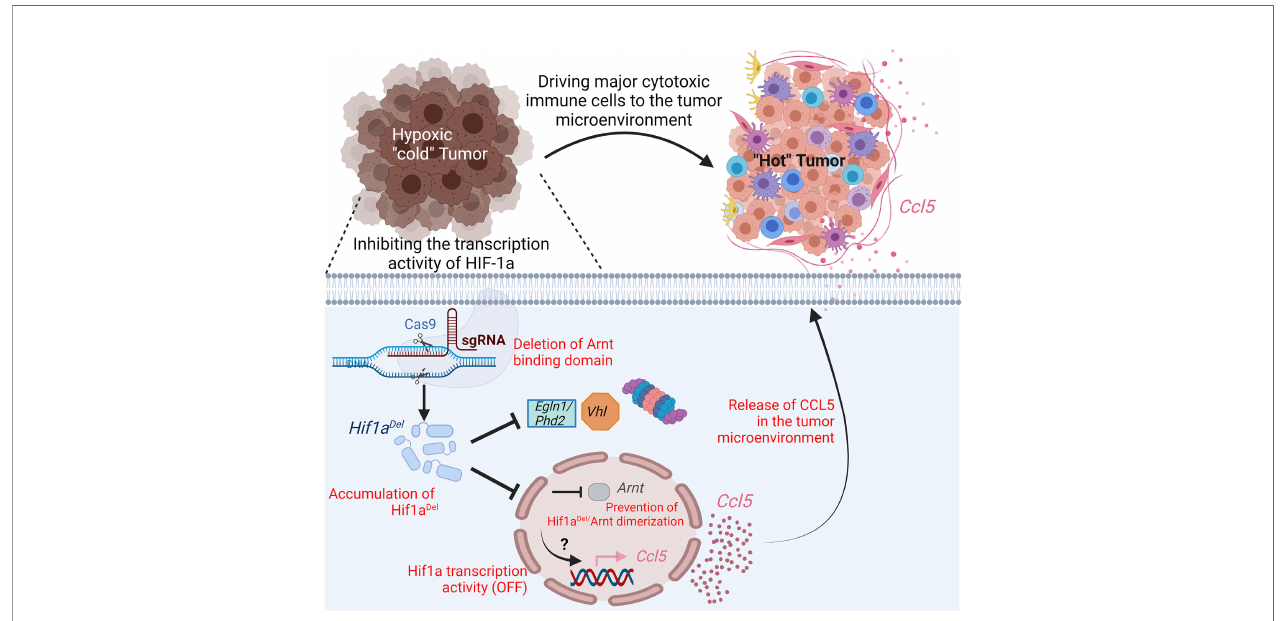
FIGURE 3 | Impact of targeting the transcription activity of Hif1a on driving immune cells into melanoma tumor microenvironment. Hypoxic melanoma are “ cold ” poorly in fi ltrated by immune cells. Deletion, in Hif1a, of the domain responsible for the formation of a heterodimer with Arnt by CRISPR/Cas9 gene- editing technology, prevents its transcription activity. In hypoxic cells expressing deleted Hif1a Del , the pro-in fl ammatory (C-C motif) ligand 5 chemokine (Ccl5) is overexpressed by a mechanism which is not fully understood. The release of Ccl5 by tumor cells in the tumor microenvironment drives major cytotoxic immune cells and contributes to the establishment of pro-in fl ammatory “ hot ”